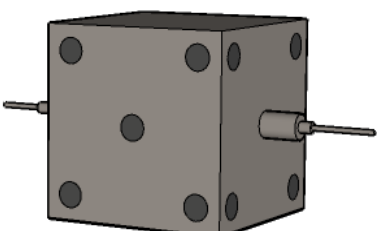
Figure 2. Simulation diagram of ultrasonic test.